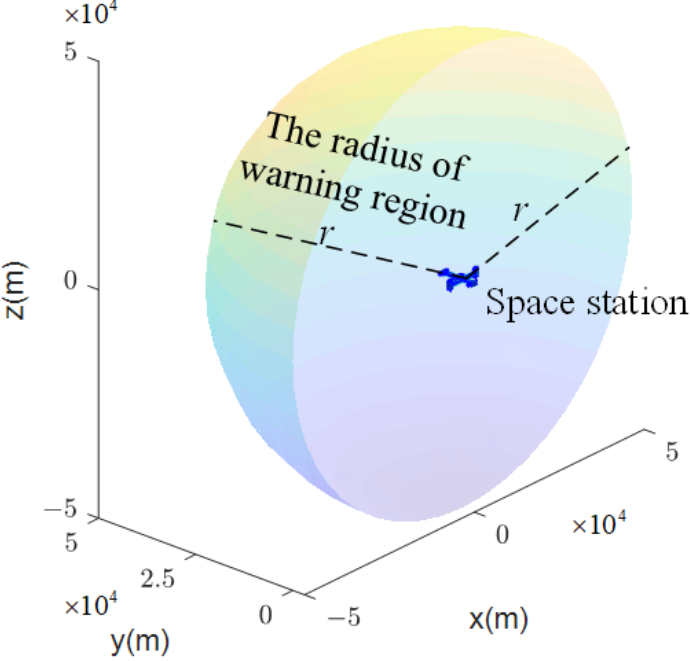
Figure 7. Early-warning region around the space